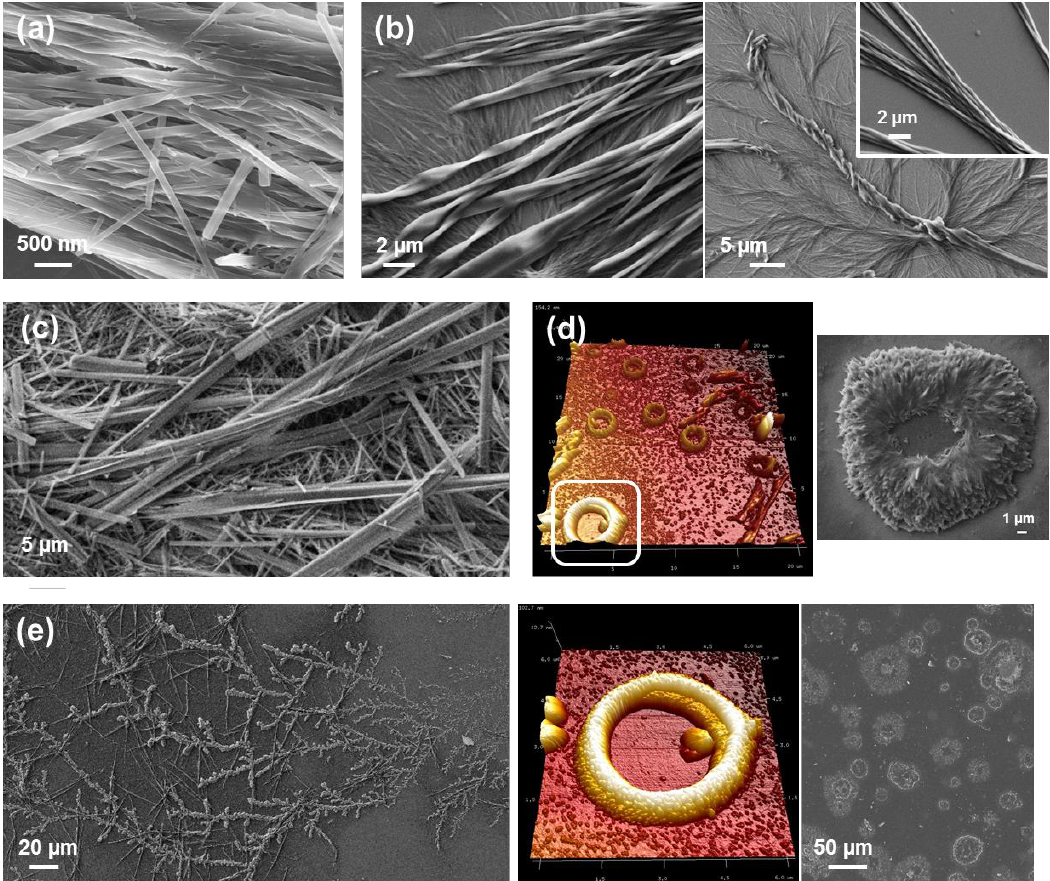
Figure 11. SEM micrographs of the structures obtained at 4 °C from TFA·FF-OFm solutions in ( a ) 4:6 HFIP:water (2 mg/mL) and ( b , c ) 1:9 HFIP:water (0.5 mg/mL) mixtures. The solution deposited in the coverslips was fresh in ( b ) while it was previously stored for 12 days at room temperature in ( c ). ( d ) AFM images (20 × 20 and 6 × 6 μm 2 at the top and the bottom, respectively) and ( d , e ) SEM images of the structures obtained at room temperature from TFA·FF-OFm solutions in ( d ) 4:1 HFIP:water (50 mM KCl) (4 mg/mL) and ( e ) 1:9 HFIP:water (50 mM KCl) (0.5 mg/mL).